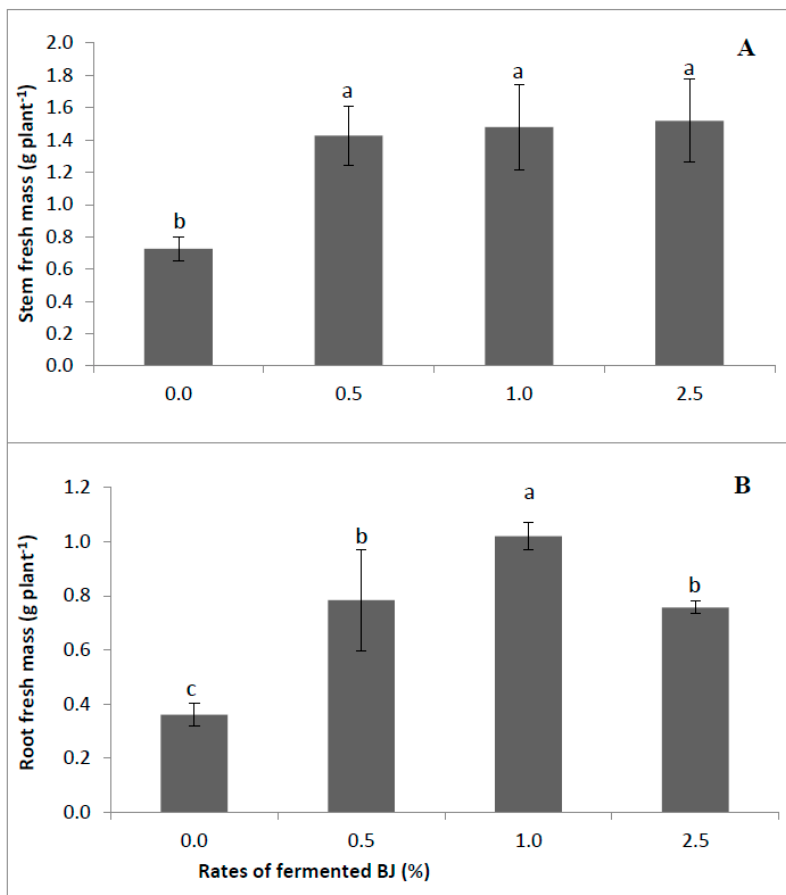
Figure 3. Fresh mass of stem ( A ) and root ( B ) of sweet basil plants treated with different rates of fermented BJ. Sample size n = 6 (mean ±SD). Different letters above the same columns show significant differences at the level of p ≤ 0.05.